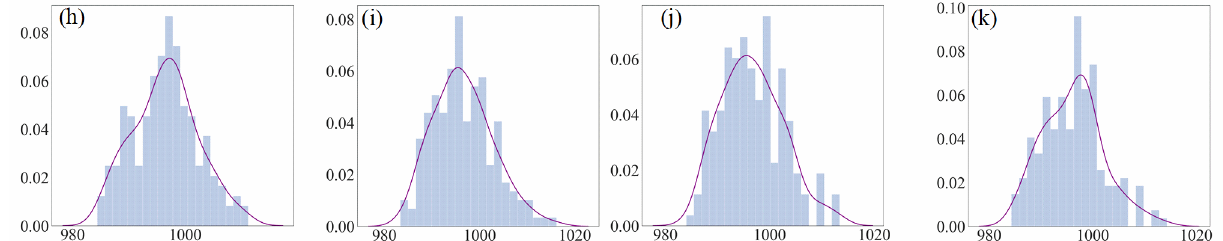
Figure 8. Changes in PDF during the successive adjustments of air pressure based on the GCM MPI simulations at the Naqu site. The upper row indicates the control observations (( a ), 1955–1969)) and the calibrated results of the three adjustments ( b – d ). The center row ( e – g ) indicates the observations for validating the calibrated results for the corresponding projection periods. The bottom row ( h – k ) indicates the raw GCM simulations in the corresponding periods. The first column: control period (1955–1969); the second to fourth columns: the first (1970–1984), second (1985–1999) and third (2000–2014) adjustments, respectively. The solid line indicates a distribution fit to the data.